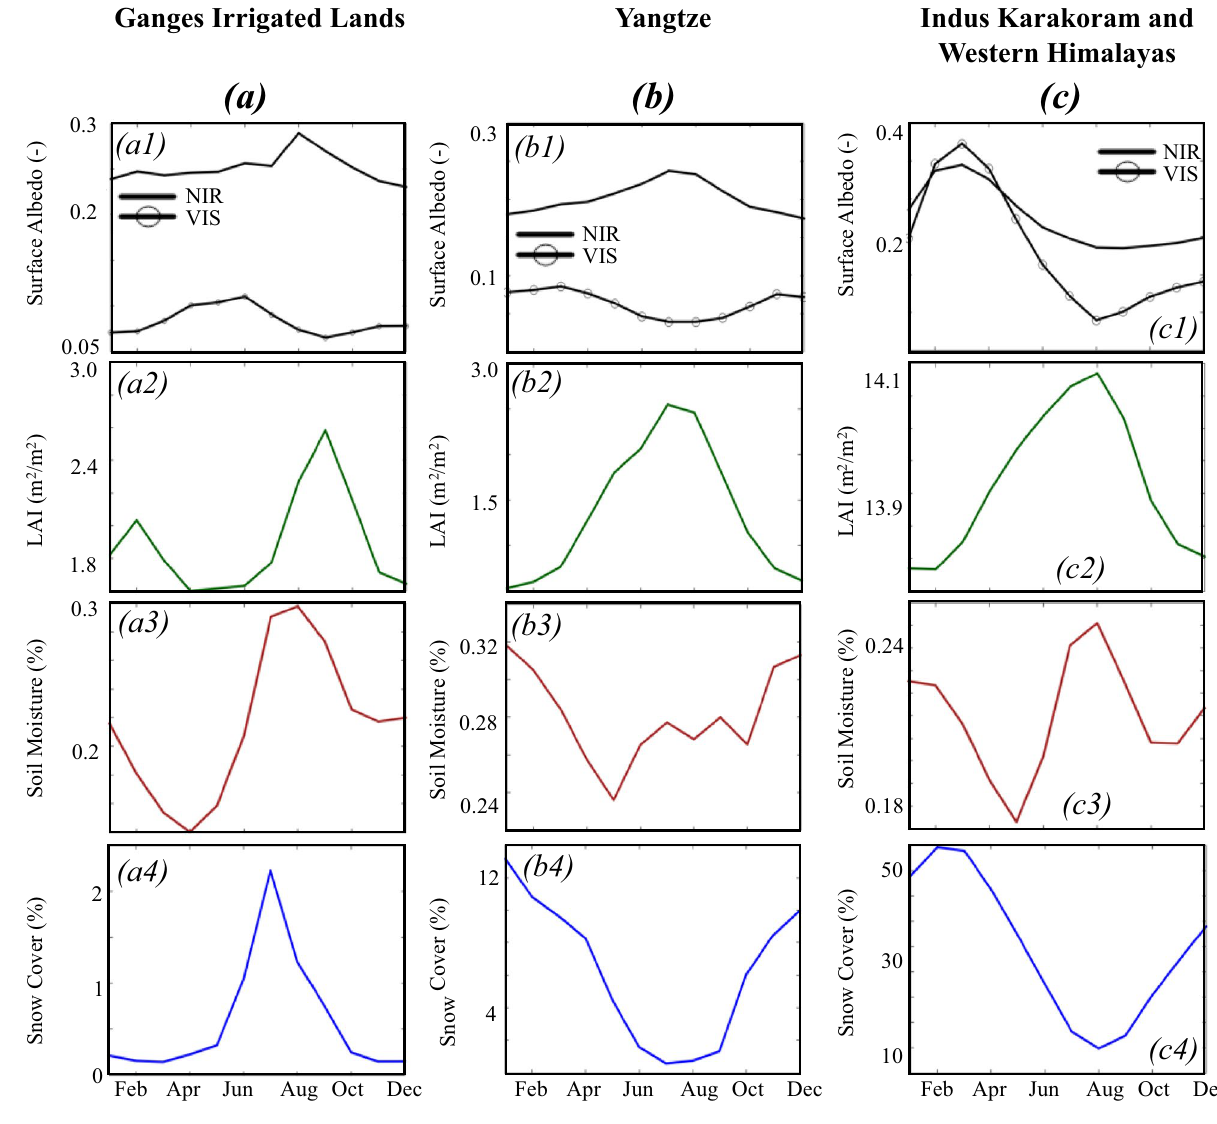
Figure 4. Monthly variations of the averages of surface albedo, LAI, soil moisture and snow cover. ( a ) in a basin where irrigation decreases surface albedo: irrigated lands of the Ganges–Brahmaputra, ( b ) in a basin where greening decreases VIS and increases NIR surface albedo: Yangtze, ( c ) in a basin where changes in snow cover decreases surface albedo: the Karakoram and Western Himalayas in the